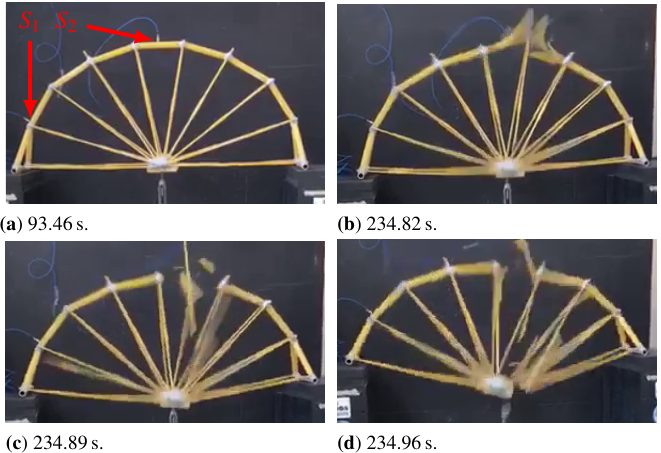
Figure 10. Damage progress over time for the studied Spaghetti